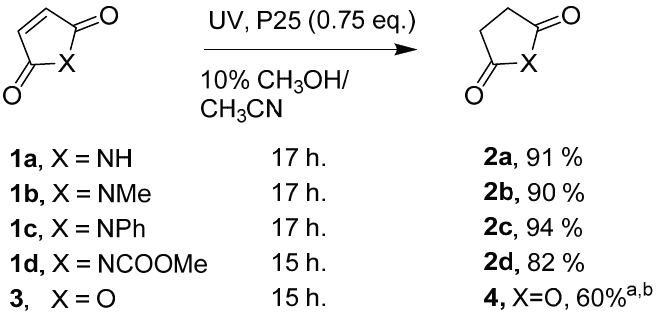
Scheme 1. P25 promoted hydrogenations of commercial maleimides and maleic